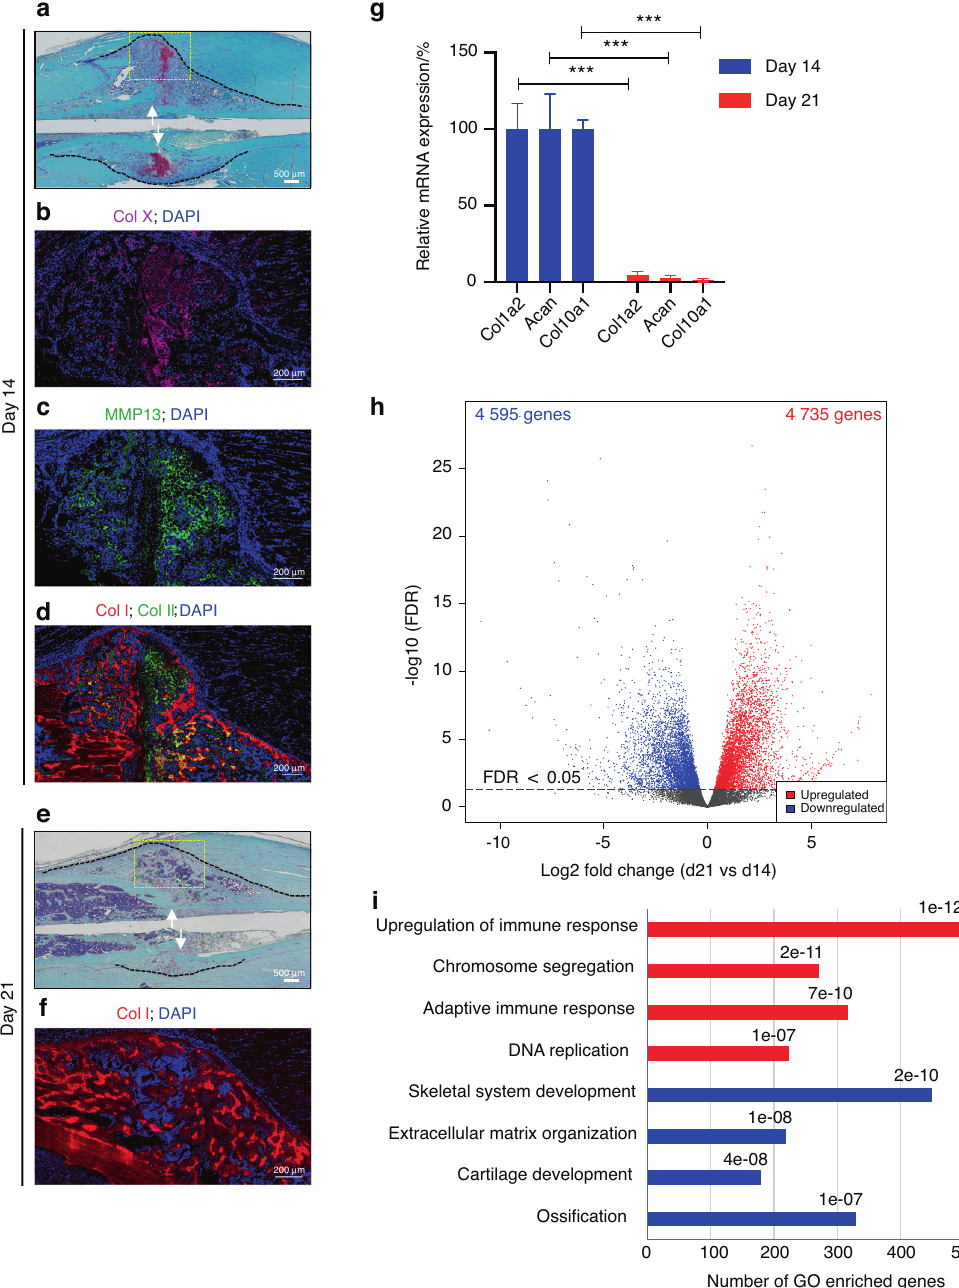
Fig. 1 Cells with higher proliferation capacity populate the callus as the cartilaginous callus that bridges the fracture gap is replaced by woven bone. a – d Staining of d14 calli. a Safranin O/fast green staining. The cartilaginous extracellular matrix of the soft callus was stained reddish orange. The white arrows point to the fracture line. The dashed black line outlines the callus. The scale bar = 500 μ m. IF staining of Col X (purple) ( b ) and MMP13 (green) ( c ). Both proteins are secreted by hypertrophic chondrocytes. d IF costaining of Col I (red) and Col II (green). Areas where both proteins are expressed (yellow) surround mineralized chondrocytes. IF images shown in b – d were captured in the region indicated by the yellow box in a . e As in a except that d21 callus samples were stained. The absence of a reddish orange stain indicates resorption of the cartilaginous callus. f As in d except that d21 callus samples were stained. The image was captured in the region indicated by the yellow box in e . The trabecular structure of woven bone bridging the fracture gap is obvious. In all the IF images, DAPI stains nuclei (blue), and the scale bar = 200 μ m. All the images are representative of fi ve callus tissues. g RT ‒ qPCR quanti fi cation of the indicated transcripts in the RNA that was puri fi ed from d14 and d21 callus tissues. Both Col1a2 and Aggrecan (Acan) are chondrocyte markers, while Col10a1 is a hypertrophic chondrocyte marker. The expression level of each transcript was normalized to that of β -actin mRNA, and the normalized level on d14 was de fi ned as 100. n = 3. The bar graphs present the average ± SEM. *** P < 0.001 using unpaired Student ’ s t test. h A volcano plot of RNA-seq data displaying the fold change in gene expression values on d21 relative to d14 (Table S1). Signi fi cantly differentially expressed genes (FDR < 0.05) are highlighted in red and blue to indicate upregulated and downregulated genes, respectively. RNA-seq data were generated from three biological replicates at each timepoint. i GO analysis of signi fi cantly differentially expressed genes shown in h . Representative examples of functional categories enriched by upregulated (red) or downregulated (blue) genes are shown, and the adjusted P value ( P adj ) for each pathway is given (see also Figs. S5 and S6a, b and Tables S2 and S3 for comprehensive lists of signi fi cantly enriched functional